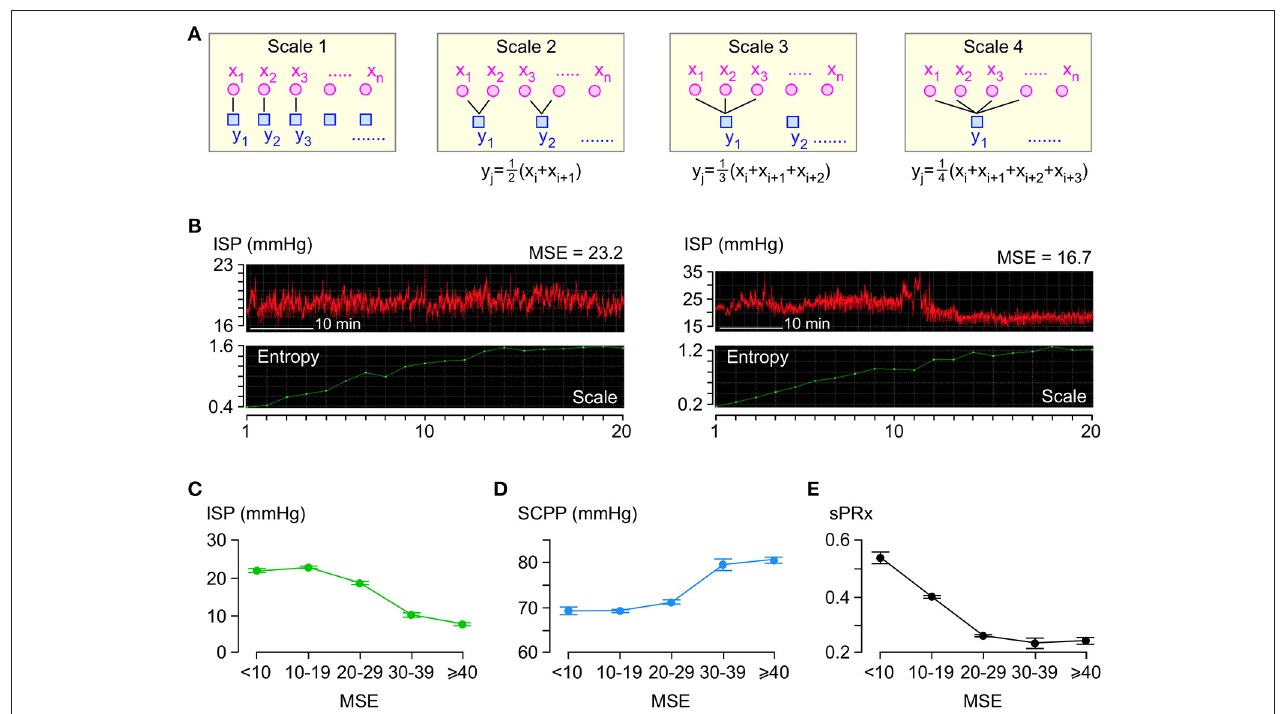
FIGURE 3 | Entropy analysis of ISP signal. (A) Coarse-graining process: For each 1h long ISP signal, multiple coarse-grained time series are generated by averaging data points x i within non-overlapping windows of increasing time length to obtain y j . (B) Examples of two raw ISP signals (red, top) and their corresponding sample entropy (MSE) vs. scale plots (green, bottom). (C) ISP vs. MSE (green). Trend-line R = − 0.94. (D) SCPP vs. MSE (blue). Trend-line R = 0.93. (E) sPRx vs. MSE (black). Trend-line R = − 0.90. For (C–E) n = 49 patients, mean ± standard error.